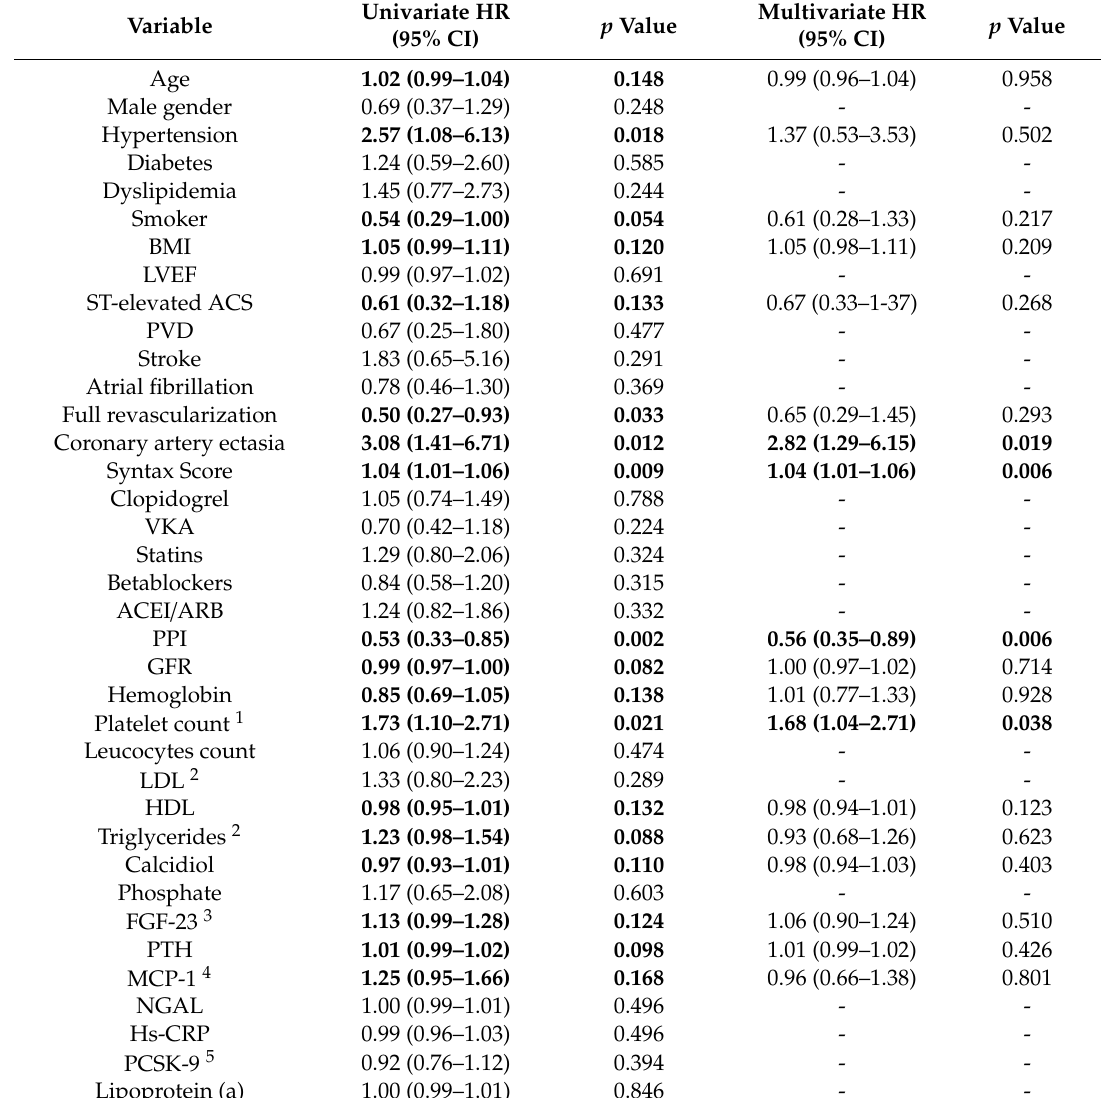
Table 3. Cox regression analysis for predictors of acute atherothrombotic events during